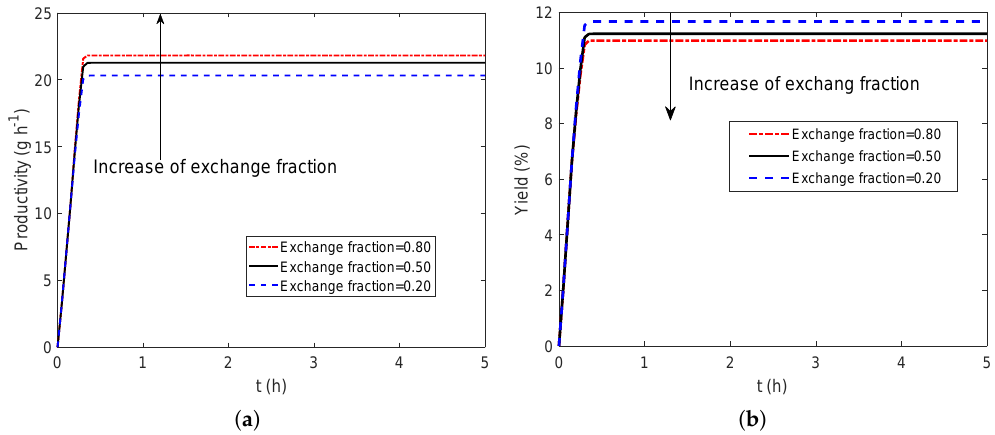
Figure 8. Effect of the amount of the liquid that has been exchanged (expressed as a fraction of the feed flow rate) on—( a ) productivity and ( b ) yield of the process. The exchange location is kept as the midpoint along the PFC. Productivity increases with the increase in exchange rate, while opposite trend is found for